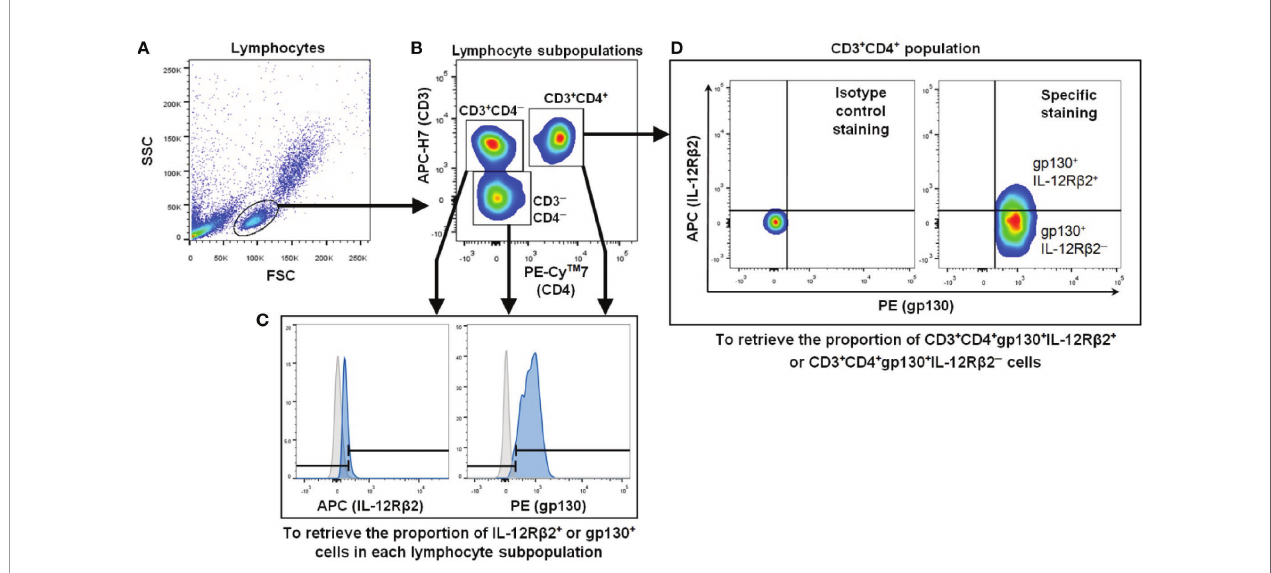
FIGURE 1 | Representative fl ow cytometry gating strategy to measure IL-12R b 2 + and gp130 + cells in lymphocyte subpopulations. (A) FSC and SSC were used to de fi ne the lymphocyte population. (B) Three lymphocyte subpopulations were gated i.e. CD3 ─ CD4 ─ , CD3 + CD4 ─ and CD3 + CD4 + populations. (C) Each lymphocyte subpopulation was examined for the proportion of IL-12R b 2 + or gp130 + cells. The gray and blue histograms represent cells stained with isotype-matched control and IL-12R b 2 or anti-gp130 mAbs, respectively. Both histograms guided the ranged gates to de fi ne IL-12R b 2 + or gp130 + population i.e. the right gate for each protein. (D) Isotype control staining (left panel) and speci fi c staining (gp130 and IL-12R b 2 staining) (right panel) gated with the same cut-off for both PE (gp130) and APC (IL-12R b 2) signals. Within CD3 + CD4 + gp130 + population, the proportion of IL-12R b 2 + or IL-12R b 2 ─ cells was determined (right